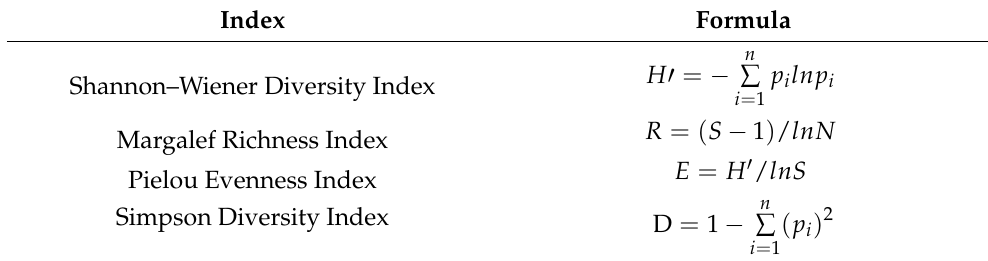
Table 2. The calculation formula of α -diversity